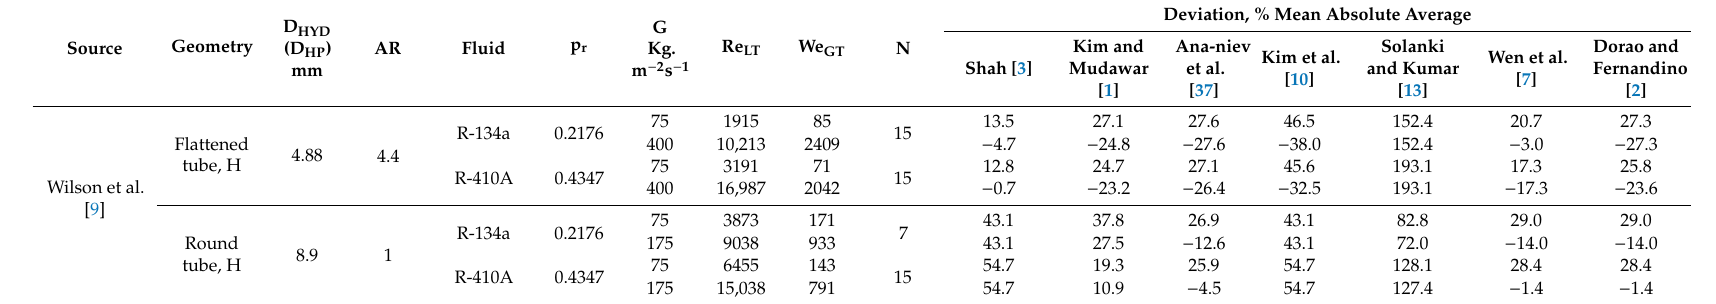
Table 3. Deviations of various correlations with data for flattened tubes and the round tubes from which they were